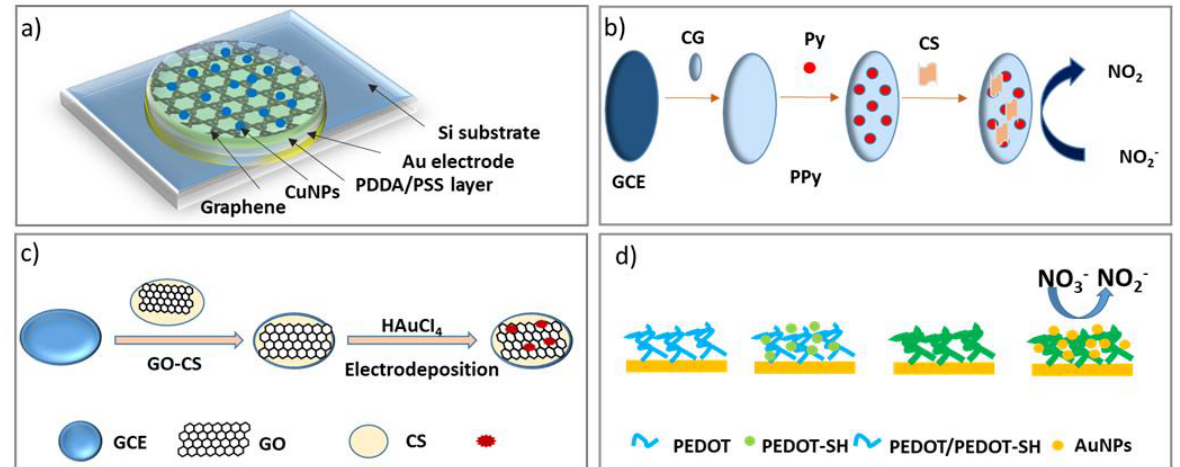
Figure 6. Redrawing of ( a ) self-assembled graphene and copper nanoparticles composite sensor structure following reference [190], ( b ) fabrication process of CG/PPy/CS/GCE for sensitive detection of NO 2 − following reference [201]. ( c ) the construction process of graphene oxide (GO)-chitosan (CS)-Au nanoparticles (AuNPs)/glassy carbon electrode (GCE) [177] and ( d ) Growth process of PEDOT/PEDOT-SH/Au on electrode surface [210].